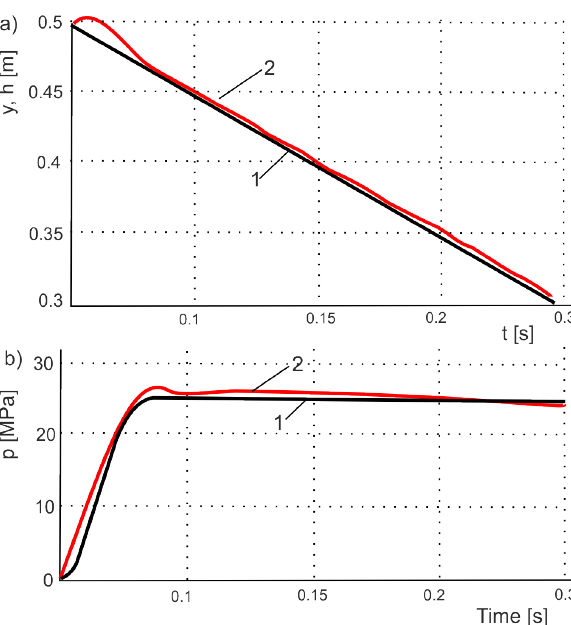
Figure 14: Trajectories comparison for optimal input signals: a) up- per beam displacement y ( t ) for the range of deformation height h ( t ) of the forgings, b) load pressure p ( t ) in the main plunger cylinder: 1 – trajectories of reference parameters, 2 – trajectories of predicted